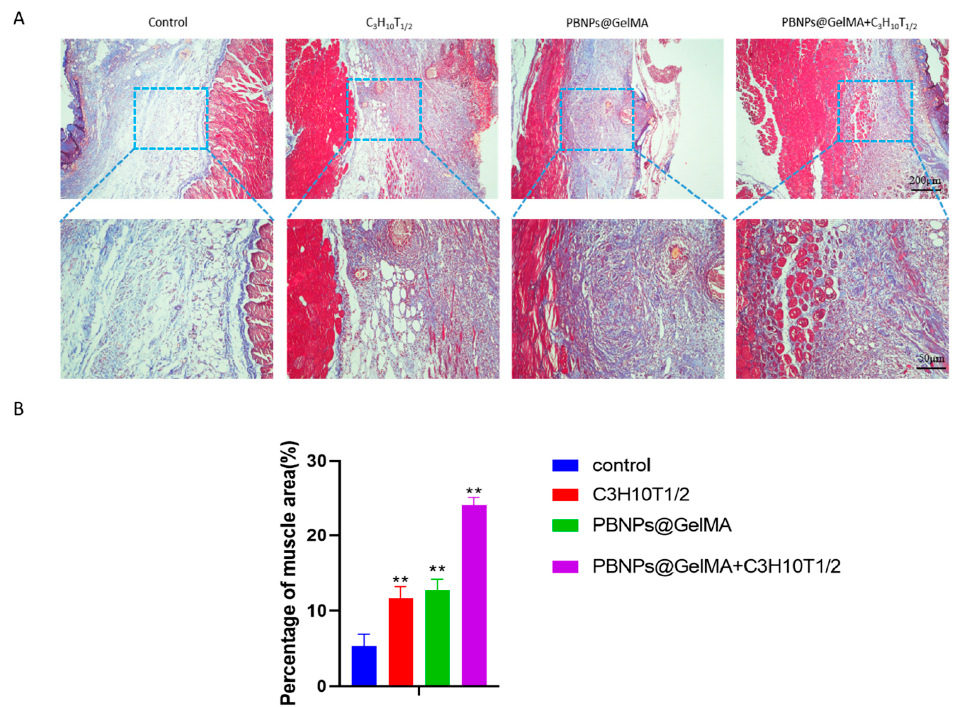
Figure 5. Observation of muscle regeneration with Masson staining in vivo. ( A ) Masson staining images of abdominal wall muscle defect treated with control, MSCs, PBNP@GelMA, and MSCs + PBNP@GelMA 2 weeks after surgery. ( B ) Statistics of percentage of muscle area ( n = 3). Samples without implants were used as a control group; ** p <